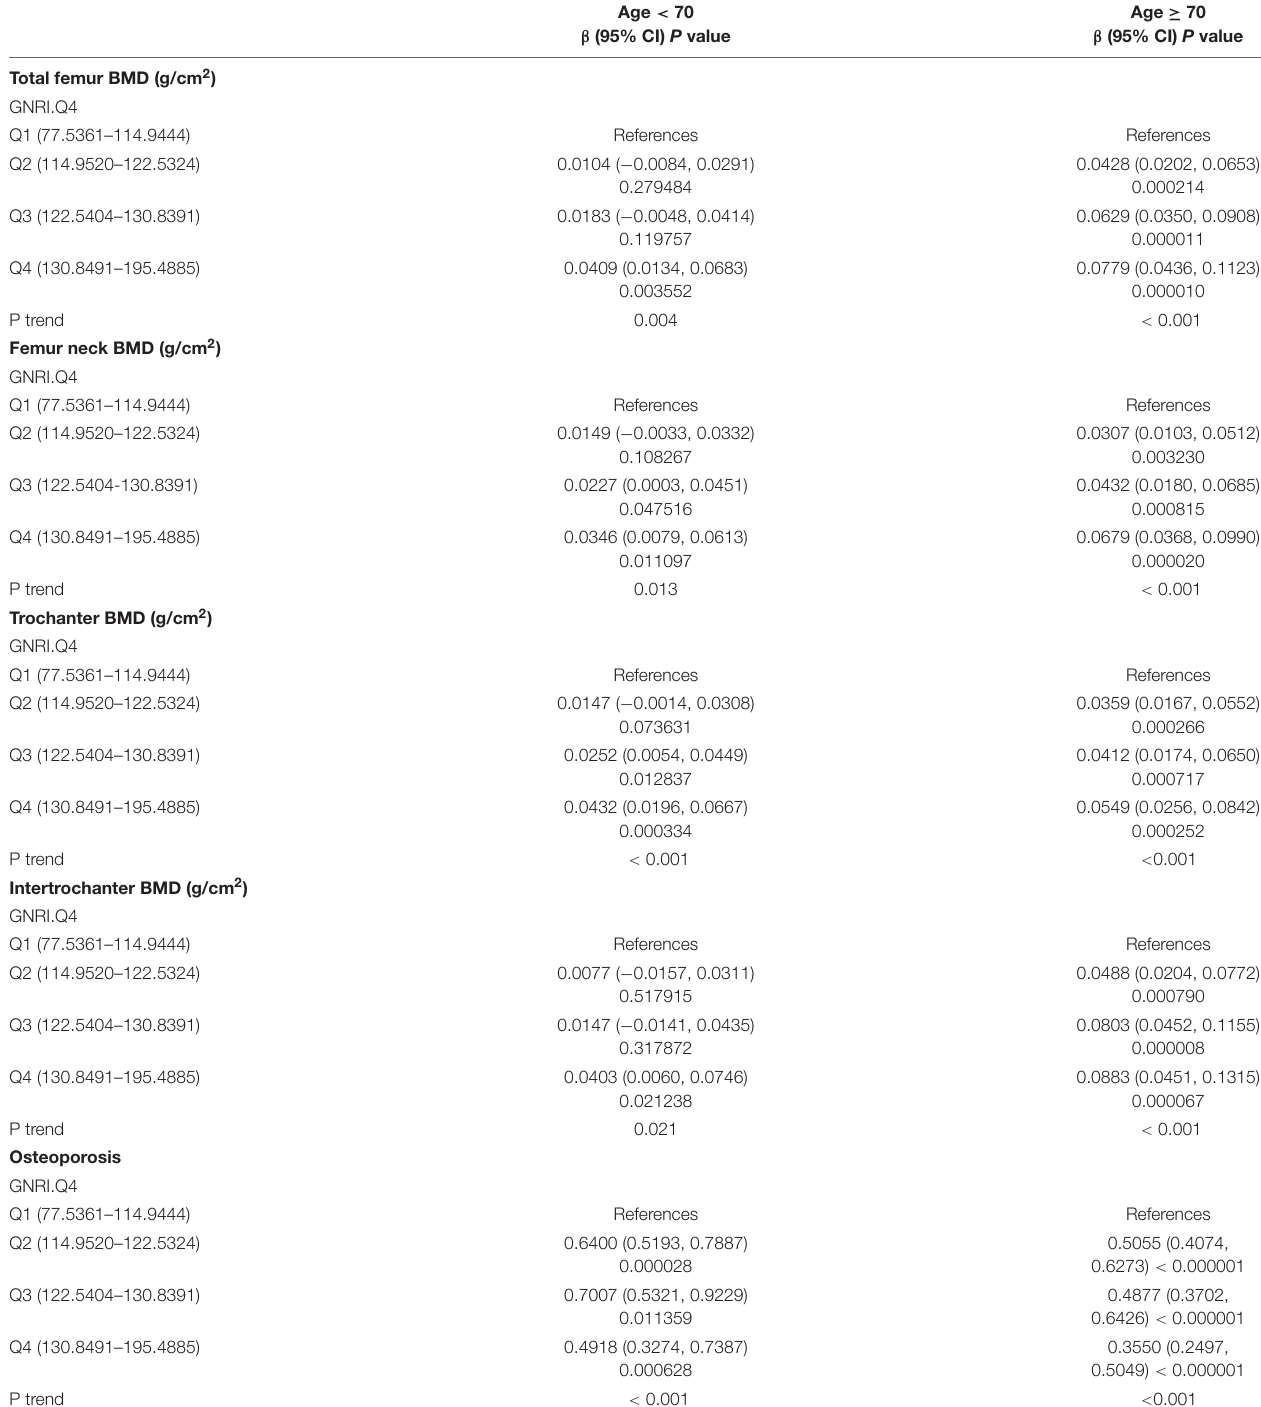
TABLE 5 | Associations of the GNRI.Q4 with femur BMD and the risk of osteoporosis stratified by